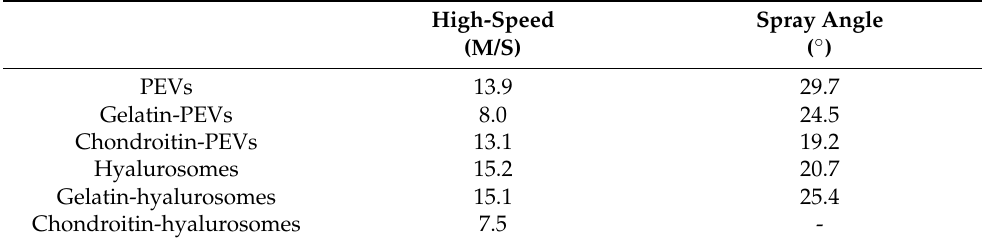
Table 3. High speed values and spray angle measured from the plume generated by C. halicacabum extract-loaded PEVs; gelatin-PEVs; chondroitin-PEVs; hyalurosomes; gelatin-hyalurosomes; and chondroitin-hyalurosomes.